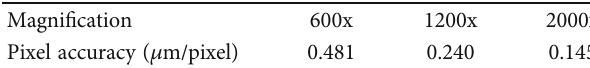
Figure 1: A sandstone sample and scanning sample. Table 1: Resolution of images with di ff erent magni fi